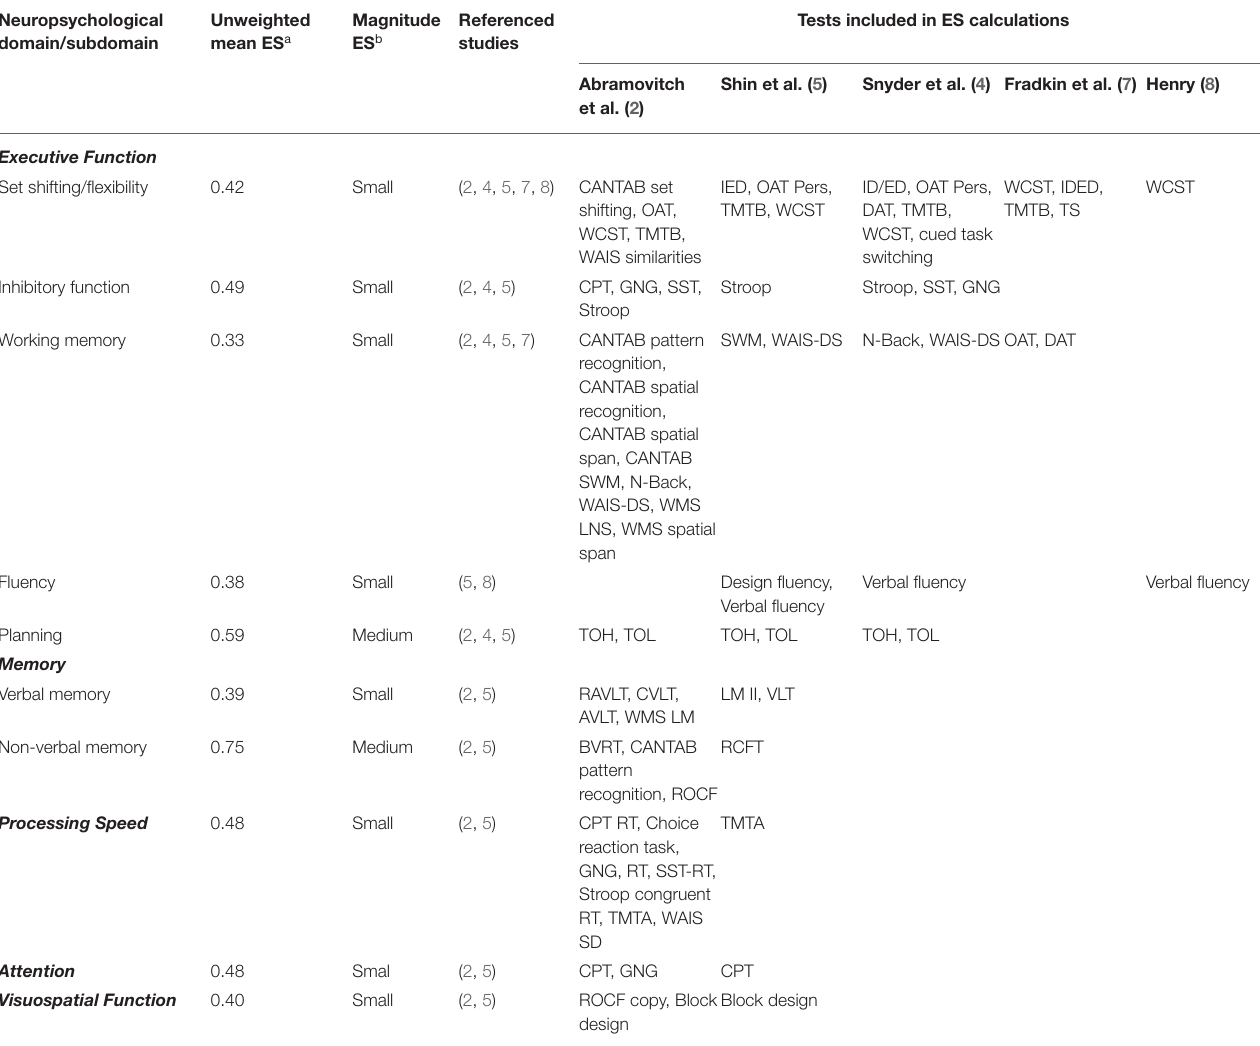
Tests included in ES calculations